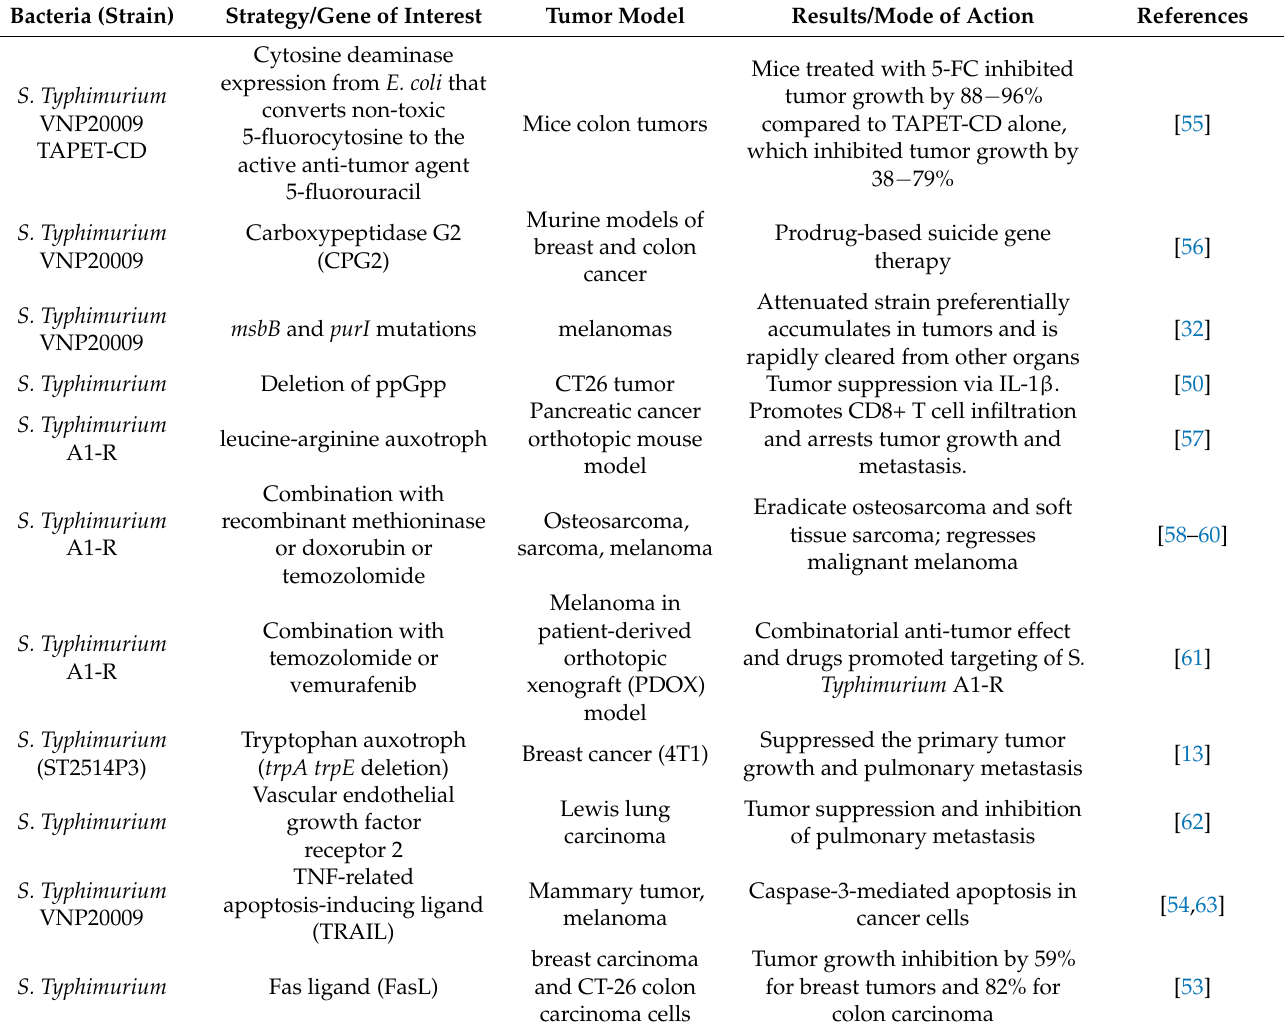
Table 1. Salmonella strains in therapeutic application in